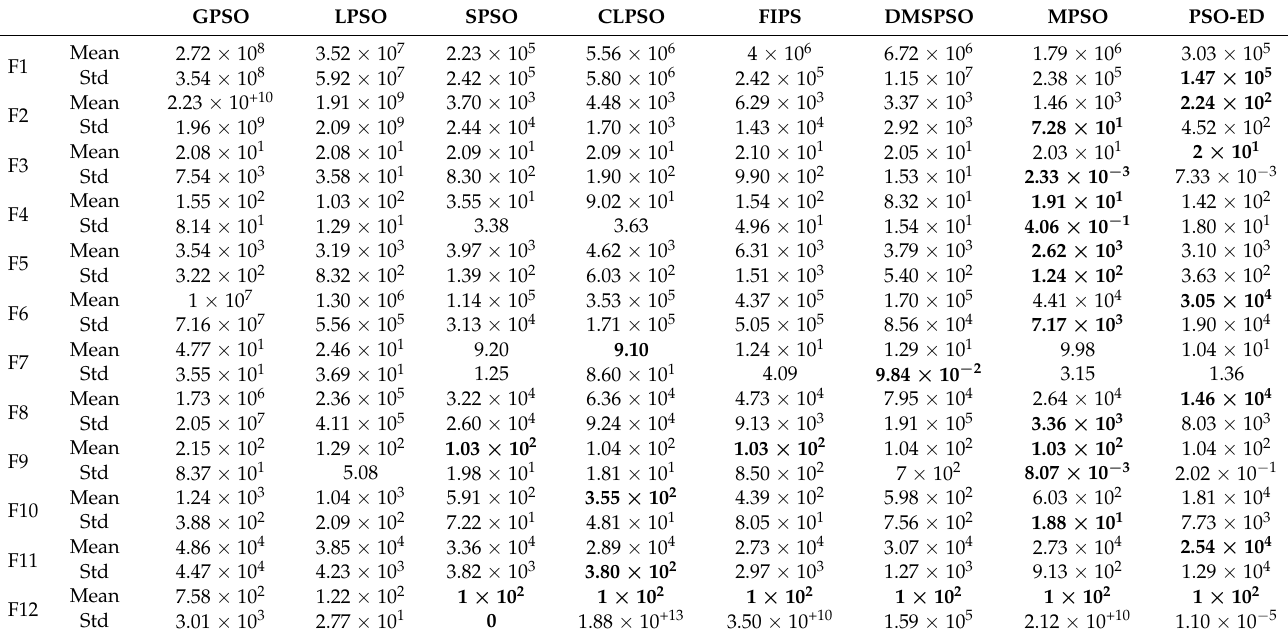
Table 7. Comparison of PSO-ED with 7 popular PSO variants for 30- D